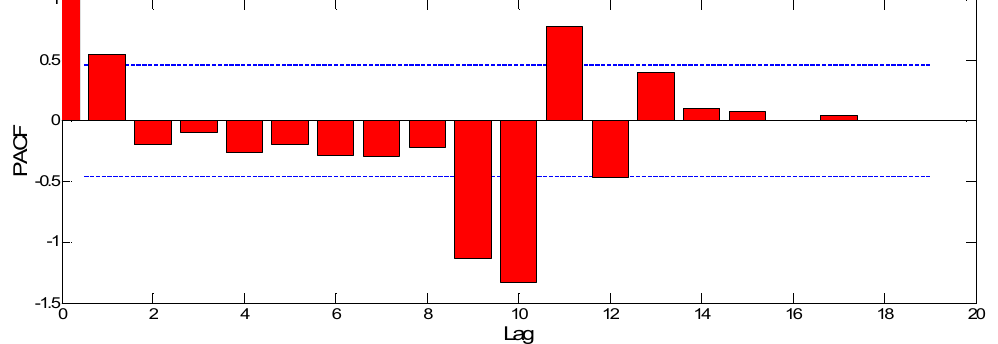
Figure 4. The PACF of the growth rates of grid-connected capacity.